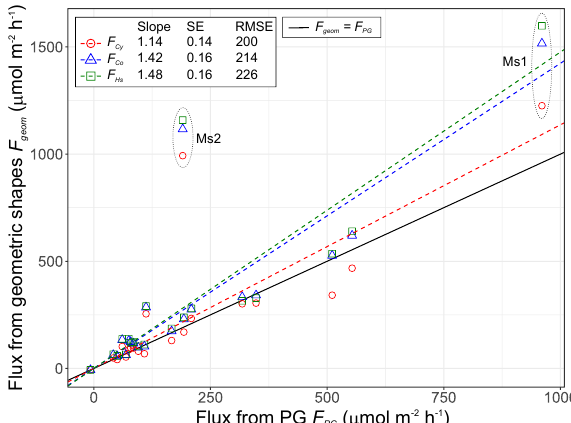
Figure 5. Comparison of areal estimates of TM macro-porosity θ M , A against volumetric estimates of TM macro-porosity θ M , V for each CT-scanned TM. Volumetric estimates were calculated from full CT scans; areal estimates were obtained via manual cross- sectioning of TMs (open symbols), and from individual CT slices in xz and yz directions (closed symbols). The latter represent the mean θ M , A ± 95% confidence intervals of the 10% of slices with the largest area, thus covering the tip (and likely the centre) of the TM.